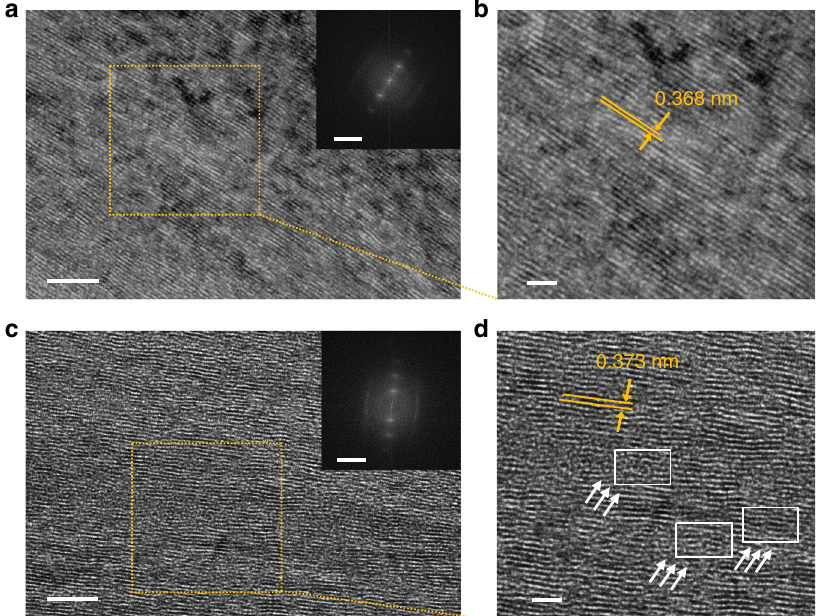
Fig. 5 Crystalline order of 8% stretching ratio and direct-cast graphene papers. a − d High-resolution TEM images of 8%-GPs ( a , b ) and direct-cast GPs ( c , d ), respectively. The insets of ( a ) and ( c ) correspond to the FFT images. Scale bars, 5 nm ( a , c ), 2 nm ( b, d ), and 5 nm − 1 (insets of a , c